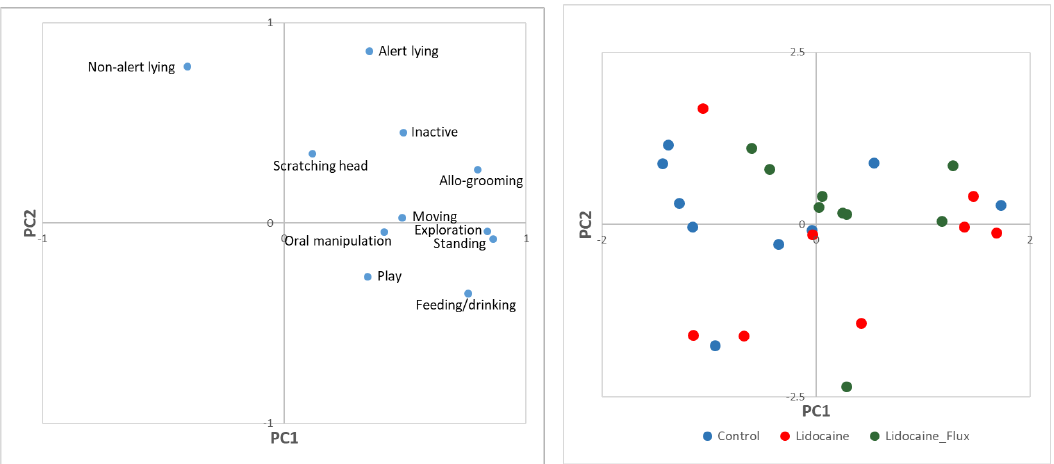
Figure 1. Results of principal component analysis (PCA) (loading plot, on the left; score plot, on the right) performed on the percentages of the time dedicated to state behaviours in the three treatments during the observation period.